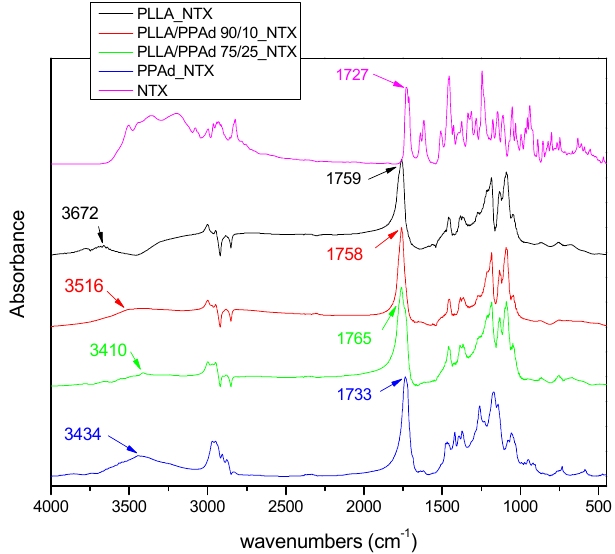
Figure 11. Fourier-transformed infrared (FTIR) spectra of neat naltrexone and prepared naltrexone microspheres with PLLA, PPAd, and PLA-b-PPAd copolymers at several weight ratios.